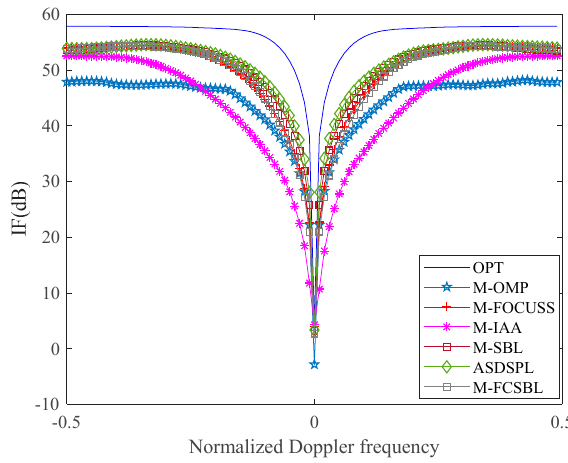
Figure 10. IF curves in the GP error case.